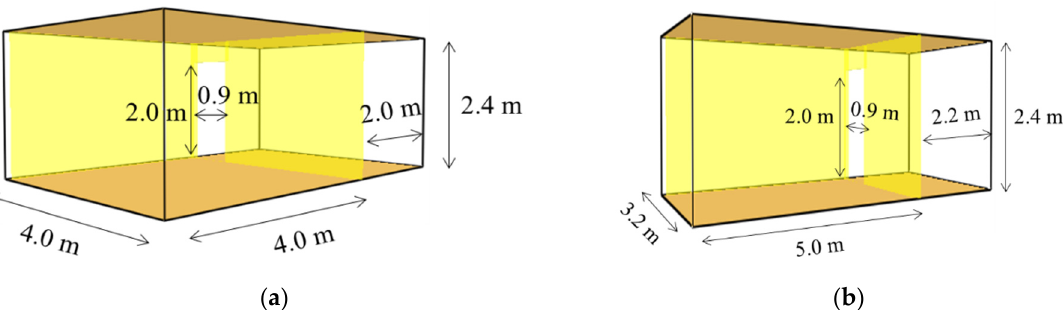
Figure 1. The dimensions of fire compartments and domain models: ( a ) square room; ( b ) oblong room. The typical sizes of both the air inlets and return air outlets were 0.6 m ( W ) × 0.6 m ( L ). The distance from each air inlet/outlet to nearby wall was 0.6 m. Figure 2 shows the location of the air inlets and return air outlets on the ceiling. The arrangement of the inlet and outlet followed Wang and Tsai [32], who revealed that the best arrangement for fire safety is to install the air inlet near the door and the return air outlet far from the door on the ceiling.